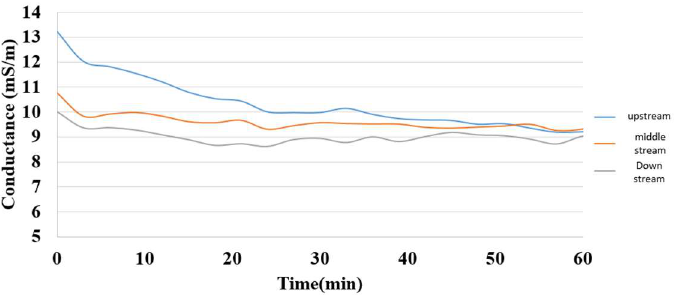
Figure 18. Internal electrical conductivity distribution during charging of the hydrogen/vanadium redox battery.